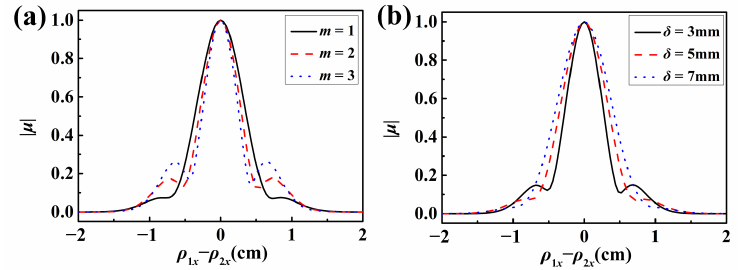
Figure 4. Cross line ( ρ 1 y − ρ 2 y = 0) of the SDOC modulus at a propagation distance of z = 300 m for various ( a ) beam orders and ( b ) coherence